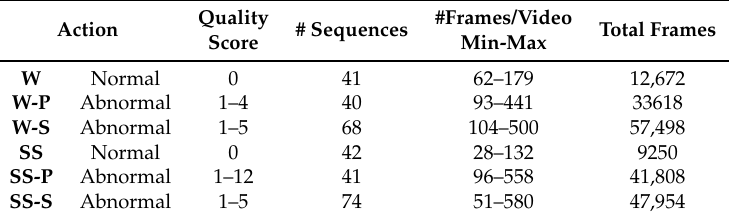
Figure 3. Sample frames from QMAR dataset, showing all 6 views for (top row) walking with Parkinsons (W-P), (second row) walking with Stroke (W-S), (third row) sit-stand with Parkinsons (SS-P), and (bottom row) sit-stand with Stroke. Table 1. Details of the movements in the QMAR dataset.